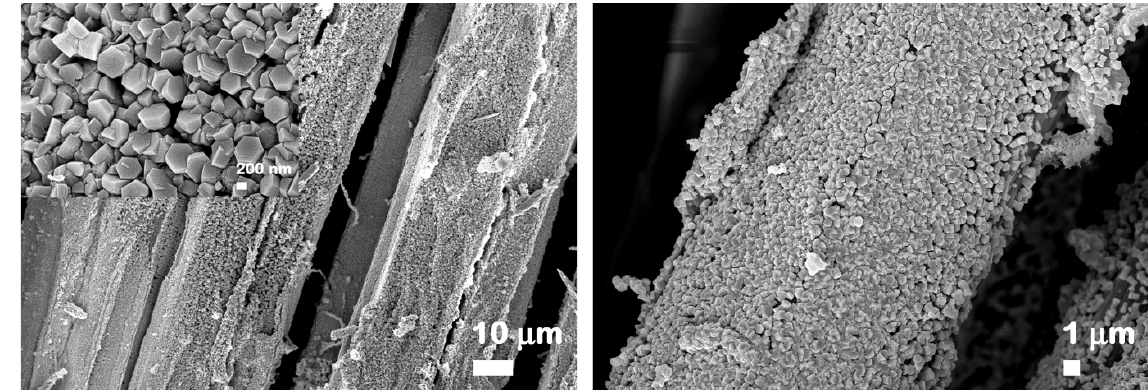
Figure 4. FESEM images at different magnifications of ZnO-coated flax fibers as yarns .